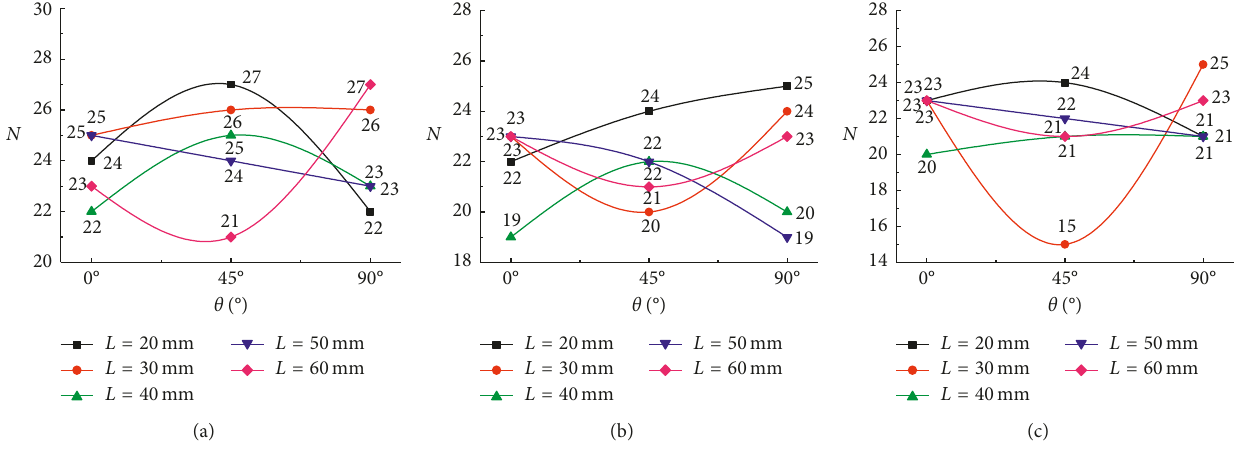
Figure 19: Relationship between θ and the total number N of cracks in numerical simulation. (a) Air; (b) soil; (c) water.